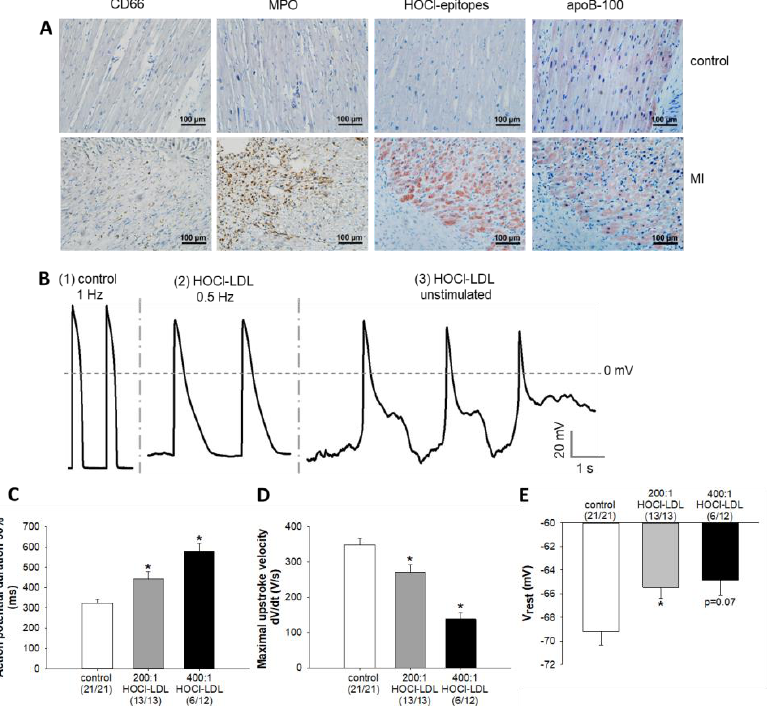
Figure 1 . Immunostaining of neutrophils, MPO, HOCl-epitopes, and apoB-100 in LV tissue, and the modulation of cardiac AP parameters by HOCl-LDL. ( A ) Representative immunostainings of neu- trophils (CD66, brown dots), MPO (brown dots), HOCl-epitopes (red), and apoB-100 (red) in the serial sections of LV from healthy volunteers (control, upper panels) and patients with myocardial infarction (MI, lower panels). Cardiomyocyte nuclei were stained blue with hematoxylin. ( B ) Rep- resentative APs of (1) control, and (2,3) HOCl-LDL-incubated (oxidant:lipoprotein molar ratio of 400:1, 250 µg/mL, 12 – 16 h) GPV cardiomyocytes that were stimulated at a frequency of (1) 1 Hz, (2) 0.5 Hz, or (3) unstimulated. ( C ) APD at 90% repolarization, ( D ) maximal upstroke velocity, and ( E ) resting membrane potential (V rest ) of GPV cardiomyocytes incubated with HOCl-LDL (oxidant:lip- oprotein molar ratio of 200:1 or 400:1, 250 µg/mL, 12 – 16 h, 1 Hz stimulation frequency). Values are expressed as mean ± SEM. ( n/n ) represents the number of myocytes showing stimulated APs/total number of patched myocytes. Cardiomyocytes showing arrhythmic events were excluded from the analysis. * indicates p < 0.05 vs. control.